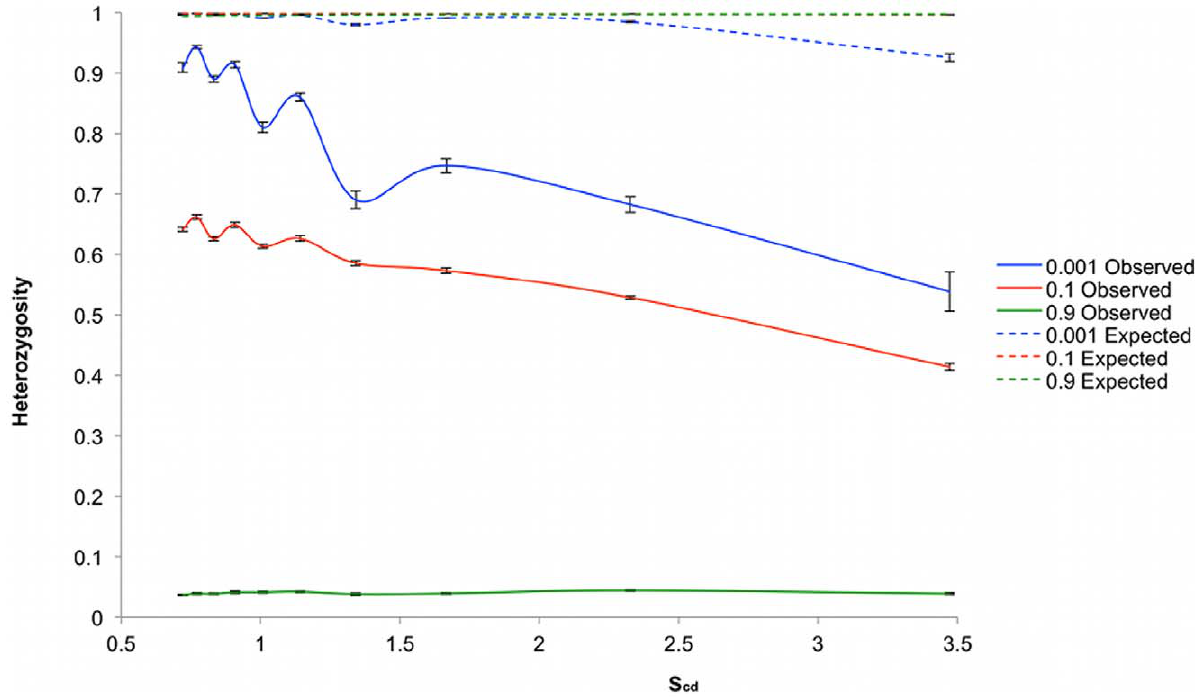
Figure 5. Heterozygosity as a function of S cd . Heterozygosity was plotted at S u =0.001 (blue), S u =0.1 (red) and S u =0.9 (green). H o is plotted with the solid line and H e using a dashed line. Simulations were repeated ten times for each value of S u , with error bars representing the standard error.